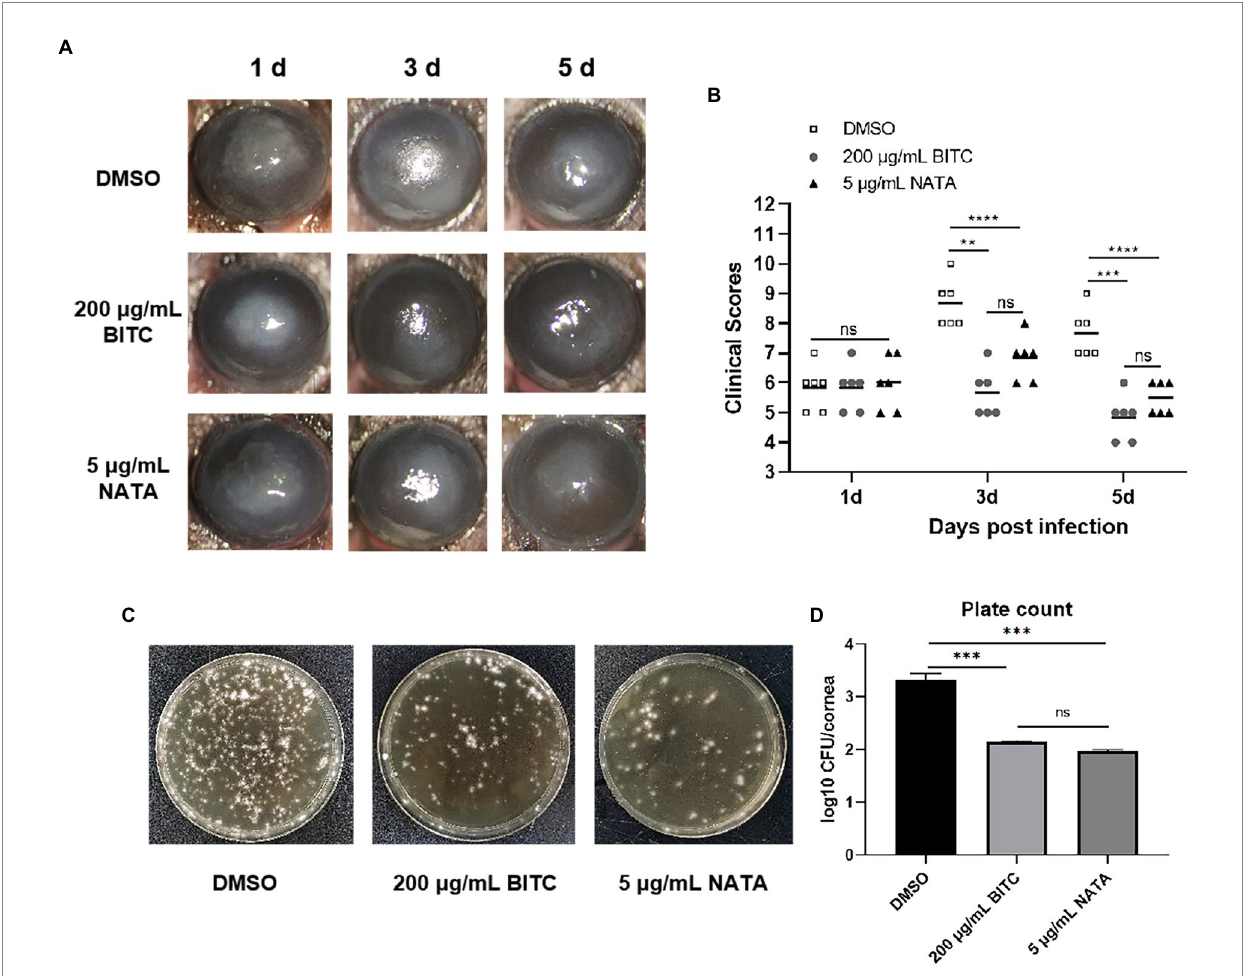
FIGURE 5 BITC is protective on A. fumigatus keratitis in mice. Slit-lamp photography (A) and clinical scores (B) for disease severity of A. fumigatus keratitis. The fungal load in corneas (C) and quantitative diagram (D) in A. fumigatus keratitis at 3 days p.i. Values represent as means ± SD (* p < 0.05, ** p < 0.01, *** p < 0.001, **** p <